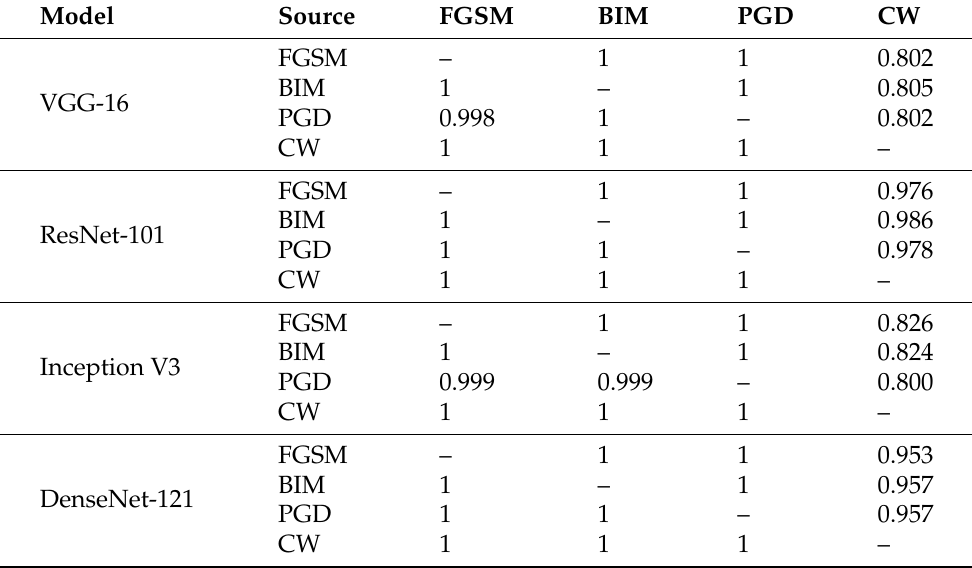
Table 6. Results of detection model transferability for multi-class DNN